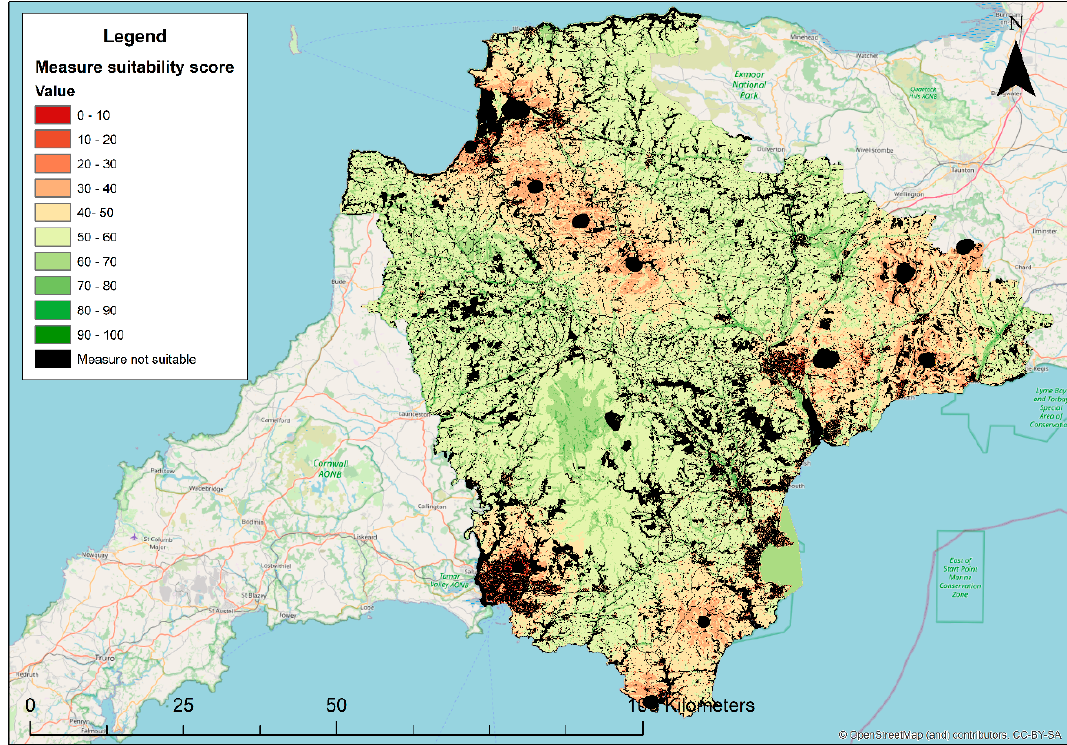
Figure 2. Opportunity map showing potential locations for constructed wetlands in Devon, indicative of upstream catchment management.